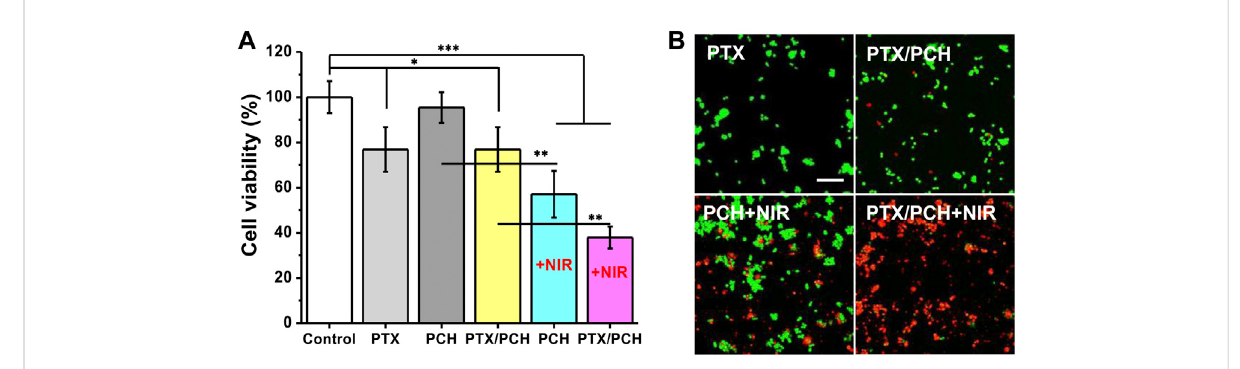
FIGURE 2 (A) In-vitro combined tumor photothermal therapy of PCH; (B) Morphology of dead/live staining of MDA-MB-231 cells corresponding to (A) . Scare bar = 50 μ